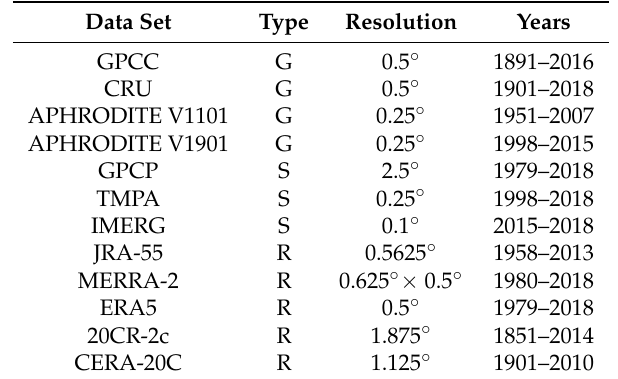
Table 1. List of precipitation data sets, their spatial resolution, and years for which they were used. Types are G = station-based gridded, S = satellite-based, R = reanalysis. See text for references and more details for each data